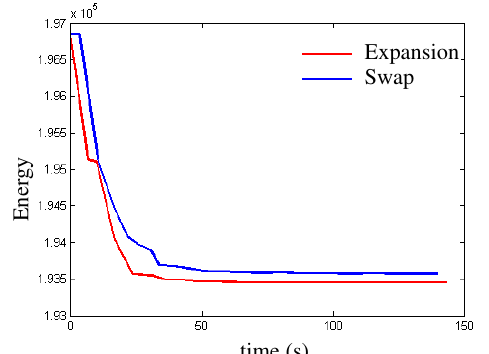
Figure 10. Energy minimization function with respect to time (in seconds) for α -expansion and α − β swap algorithms ( T = 0 and λ =